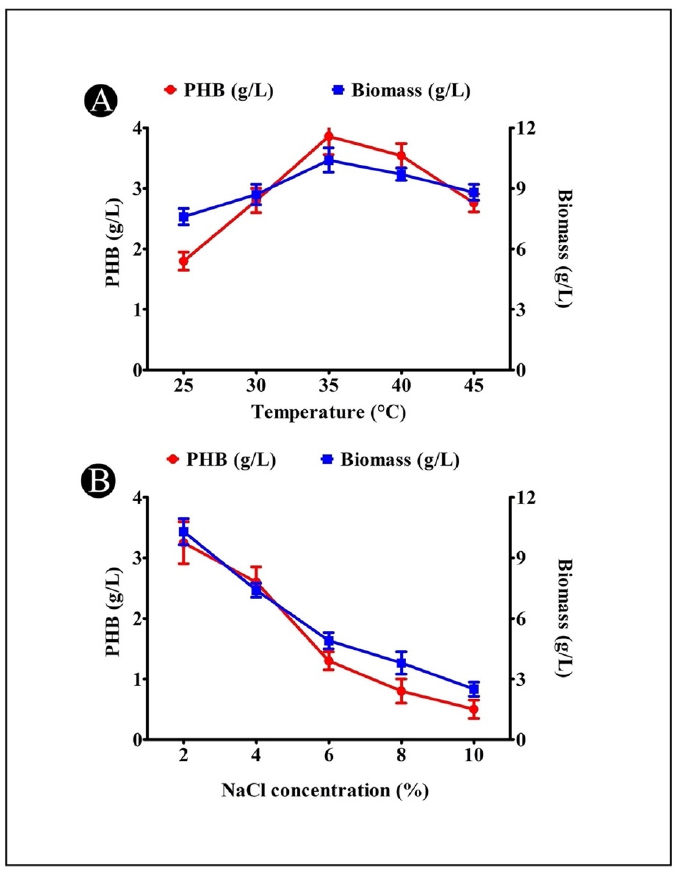
Figure 4. ( A ) Effect of incubation temperature on PHB production by A. indicus strain B2; ( B ) effect of NaCl concentration on PHB production by A. indicus strain B2.